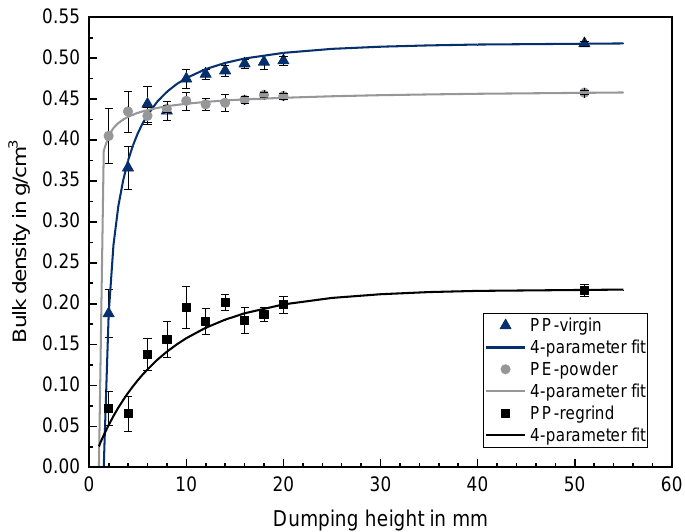
Figure 5. Bulk density measurements for increasing dumping height and respective 4-parameter-fits for the virgin PP, the regrind PP and the powdery PE. Table 1. Bulk density fit parameter as well as the calculated bulk density values for the three different areas in the grooved solid conveying zone.